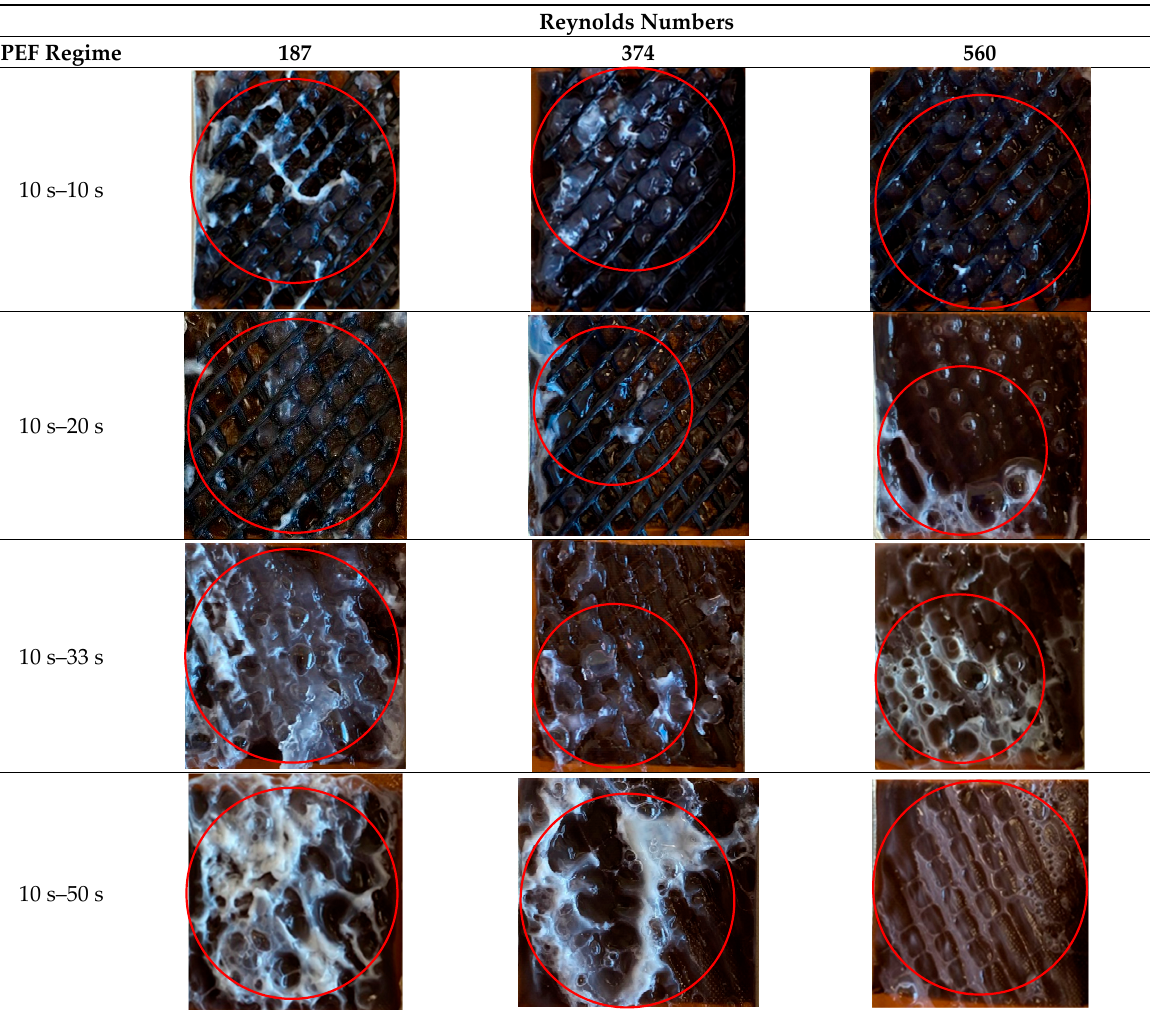
Figure 4. Evolution of pH in the KCl stream as a function of the amount of transferred charges (in